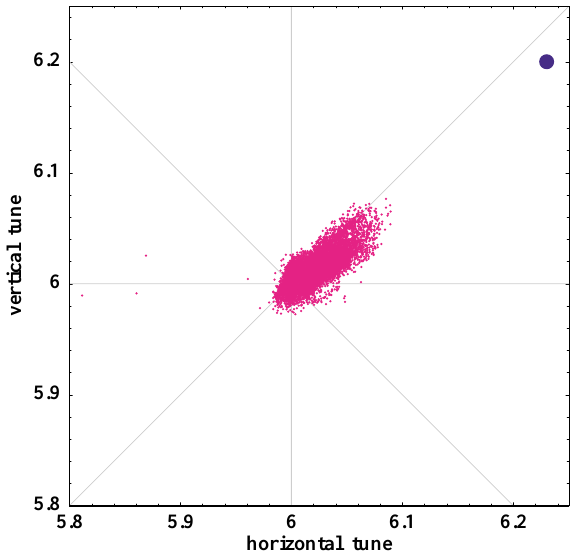
FIG. 8. (Color) Tune footprint of a KV beam after saturated beam increase (at 100 turns) due to the coherent resonance for ˜ N (cid:1) 9.7 .